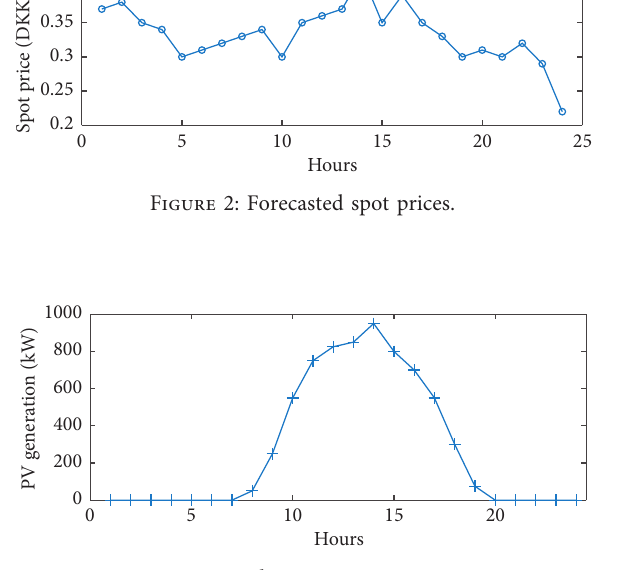
Figure 3: Forecasted PV active power generation.